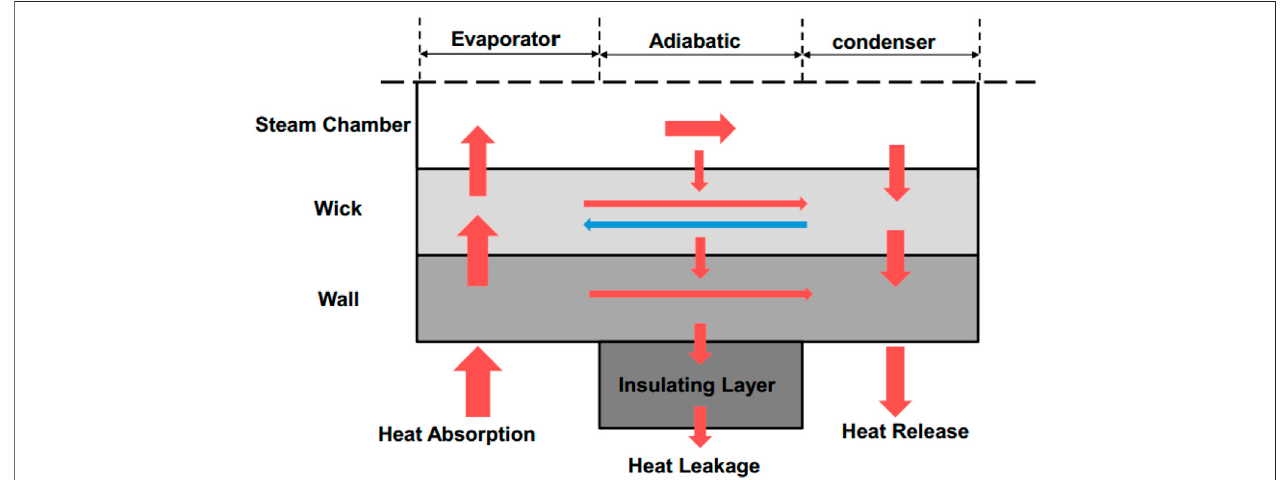
FIGURE 20 | Vapor temperature distribution in different